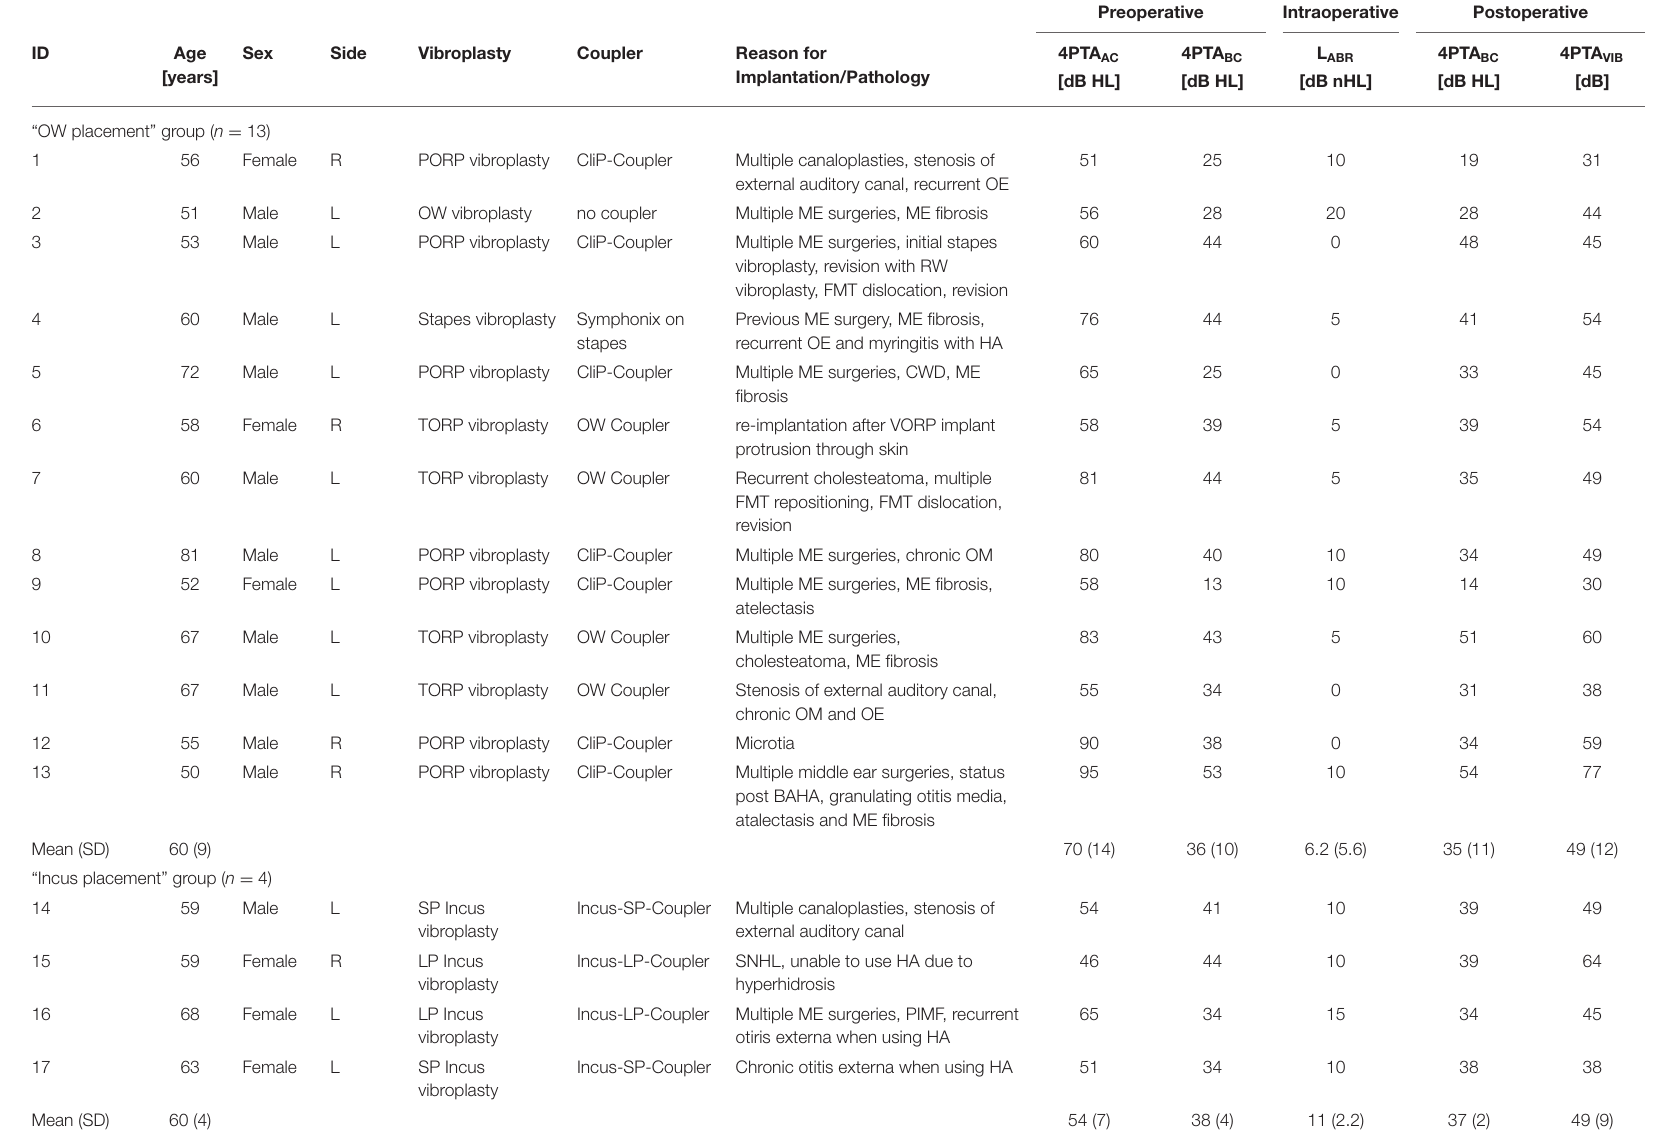
TABLE 1 | Patients’ demographics and audiological results.